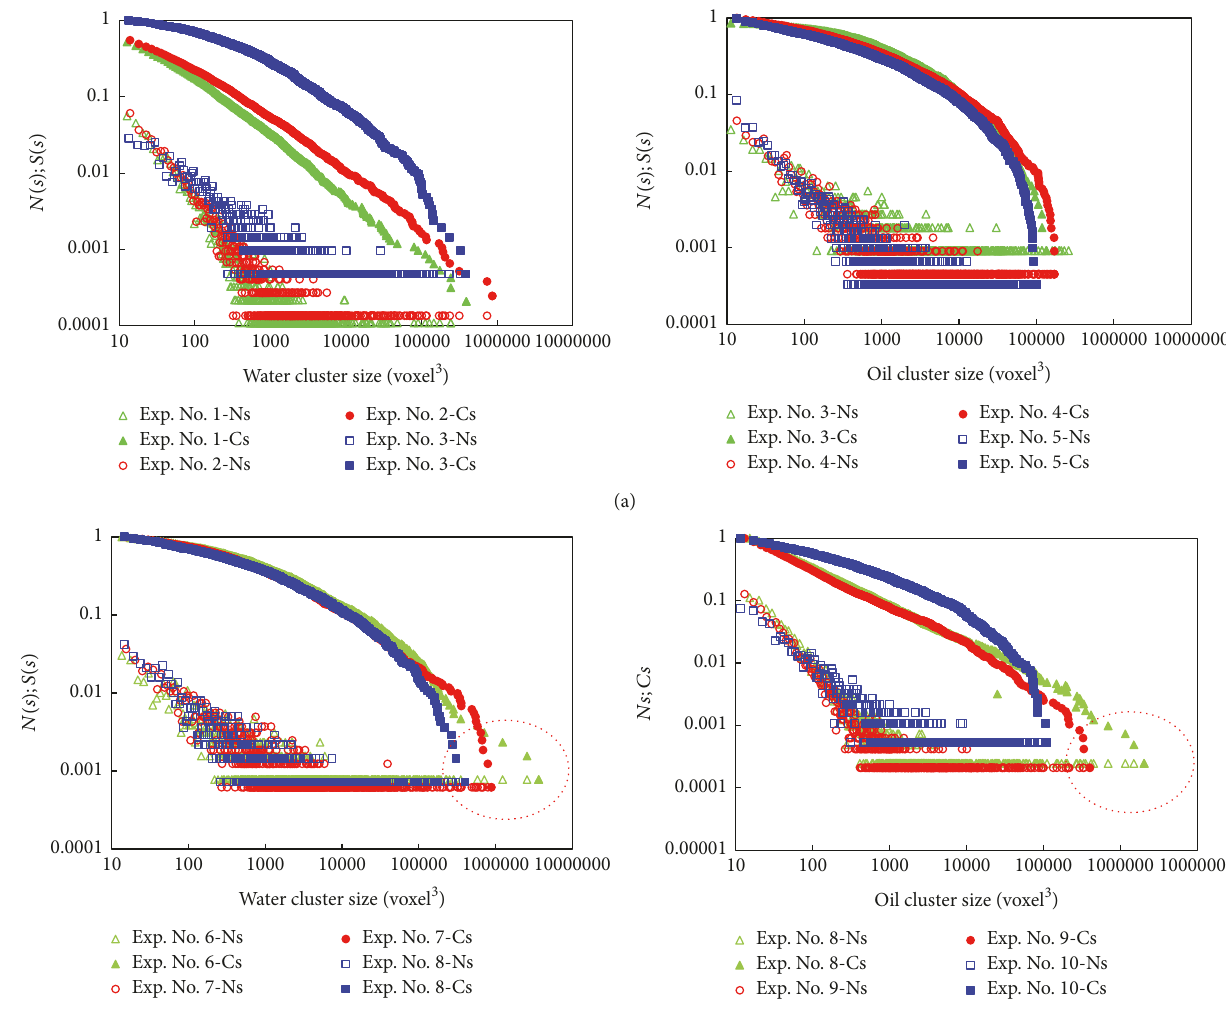
Figure 6: Water and oil cluster size distributions for the displacement process: (a) water-wet plug and (b) oil-wet plug. 𝑁(𝑠) is the normalized distribution and 𝑆(𝑠) is the cumulative normalized distribution.